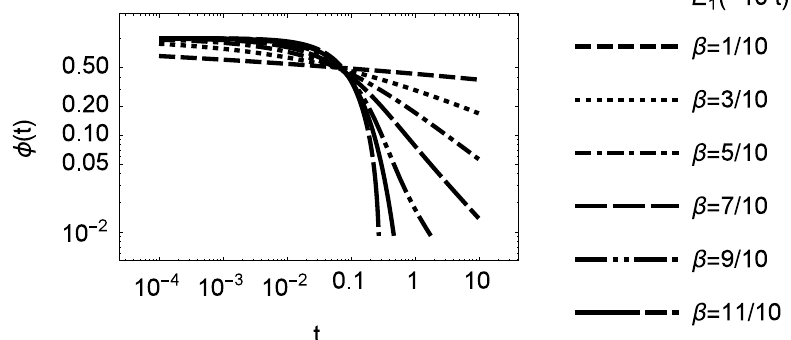
Figure 4. Approximations of the fractional relaxation Equation (84) using different fractional orders (cid:12) . The initial condition and the relaxation time (cid:28) (cid:28) = 1 = 10 . The solid line represents the analytic solution E 0 of the Caputo representation used N = 64 Sinc